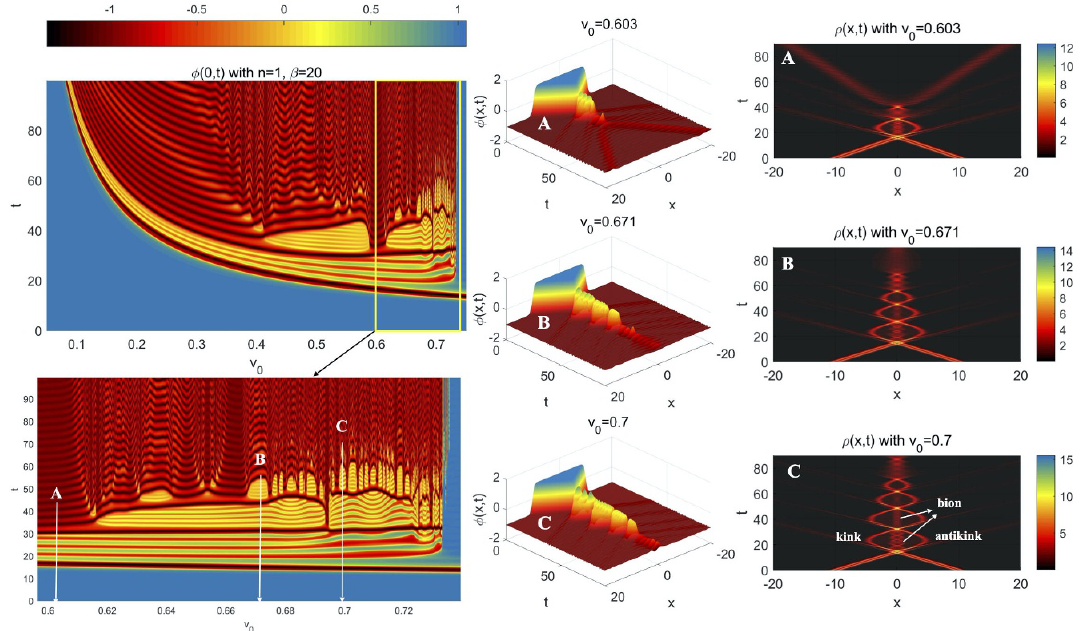
Figure 10 . (cid:30) ( x = 0 ; t ) as a function of v 0 for n = 1 ; (cid:12) = 20. In this case, we can see the formation of kink-bion-antikink intermediate states. There are also some two-bion escape windows, one locates around point A ( v 0 = 0 :